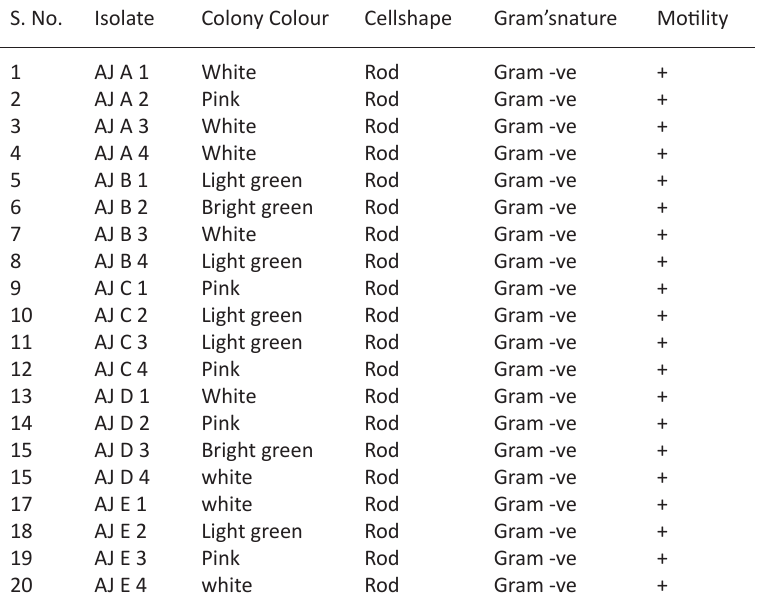
Table 2. Morphological characteristics of primary isolates S. No.